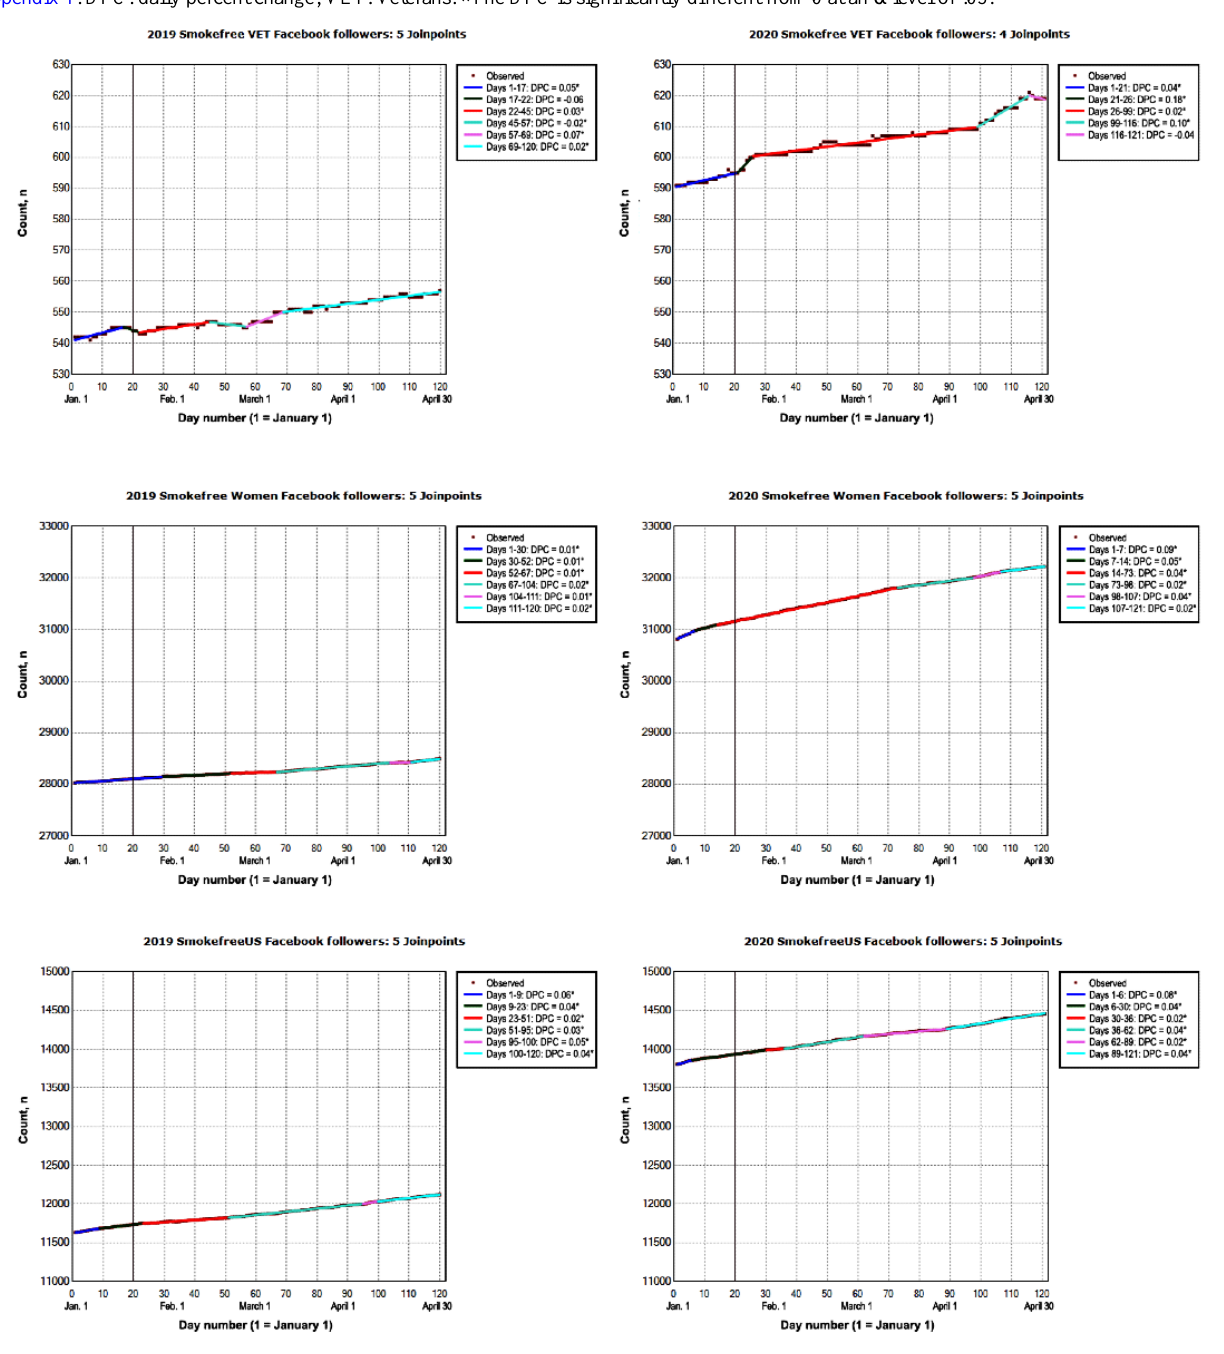
Figure 2. The number of SmokeFree VET Facebook, SmokeFree Women Facebook, and SmokeFreeUS Facebook followers from January to April 2019 and 2020. The vertical line represents January 20. On this day in 2020, the first laboratory-confirmed COVID-19 case was identified in the United States. This was reported to the Centers for Disease Control and Prevention on January 22, 2020 [43]. Data on model selection appear in Multimedia Appendix 1. DPC: daily percent change; VET: Veterans. *The DPC is significantly different from 0 at an α level of